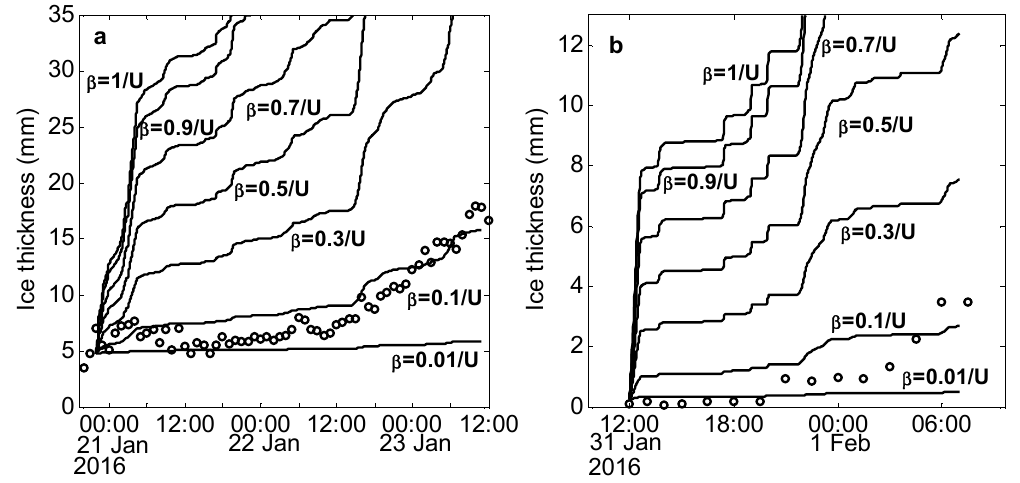
Figure 9. Ice thickness simulation results using the wet snow ice accumulation model: ( a ) case 1 and ( b ) case 2.